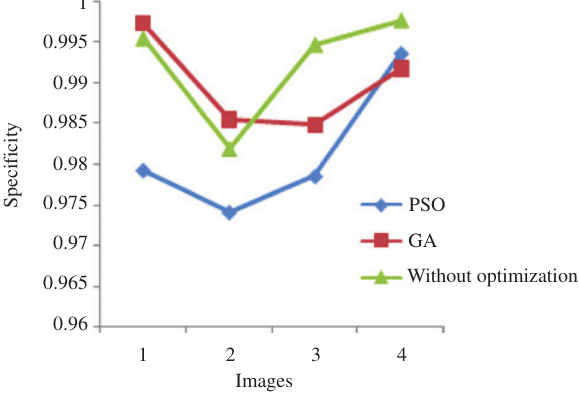
Figure 7: Specificity Graph for Three Optimization